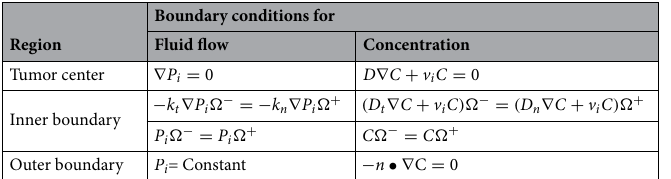
Table 4. Boundary conditions used in this study. (cid:31) − and (cid:31) + demonstrates the tumor and healthy tissue at the boundary,